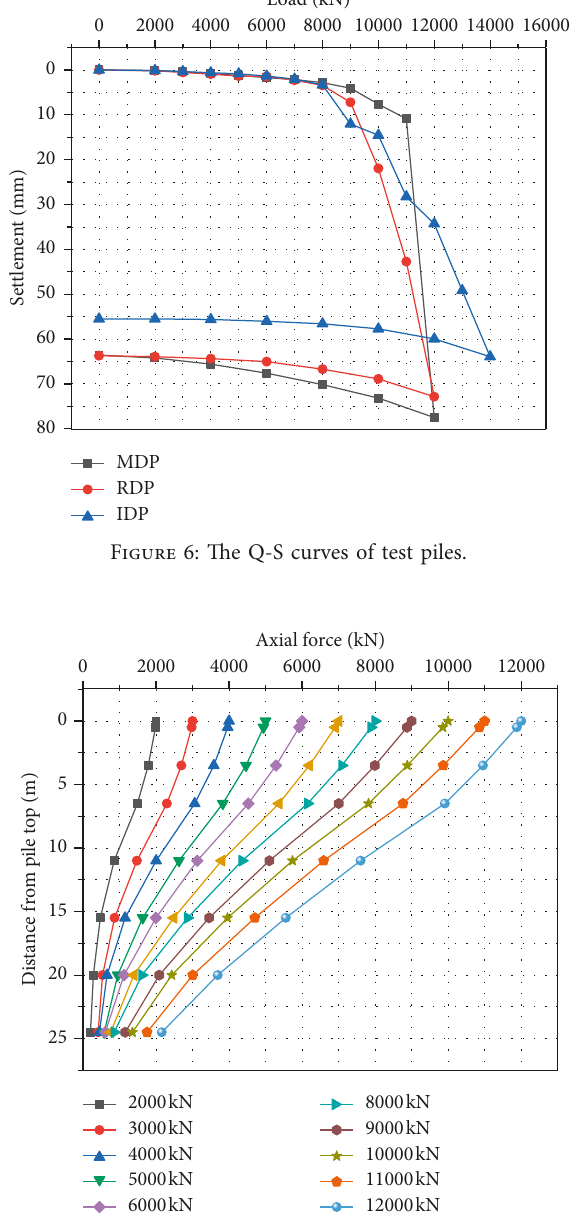
Figure 9: The axial force of IDP.